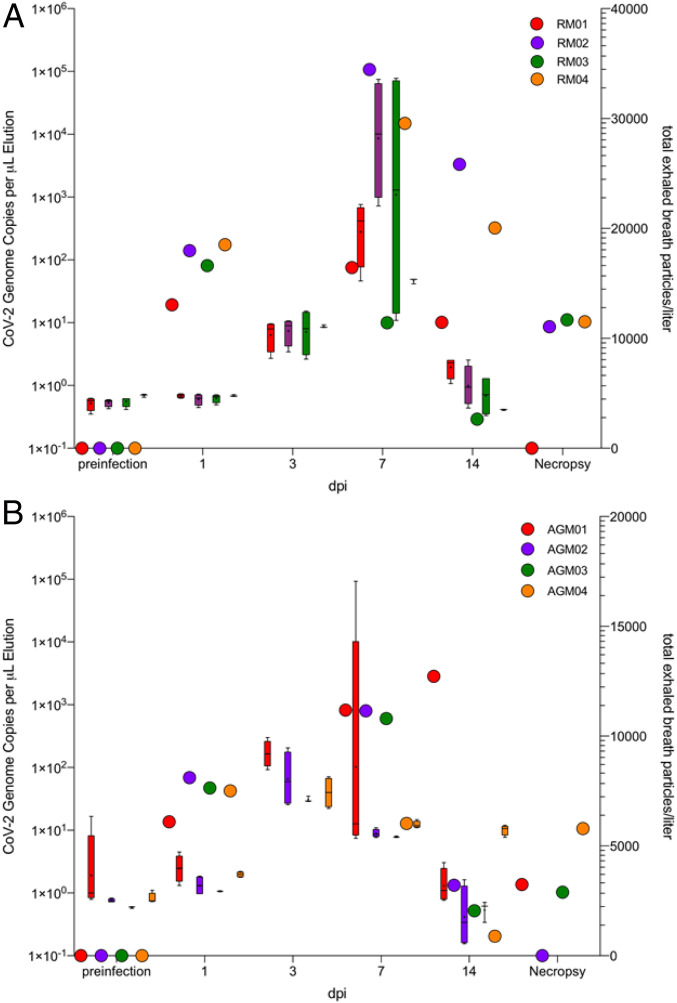
Exhaled breath particles and corresponding genomic SARS-CoV-2 viral RNA in experimentally infected (A) rhesus macaques (RM) and (B) African green monkeys (AGM). Both groups are segregated by species (n = 4; n = 8). The corresponding color-matched box-and-whisker plots of total exhaled breath particles represent iterative five 1-min sampling events to genomic viral RNA (color-matched circles) for each animal at each respective time point. Mean calculated correlation between time point-matched exhaled breath particle production and genomic viral RNA showed statistically significant correlations in 75% of the RM (RM01, r2 = 0.93, P < 0.03; RM02, r2 = 0.99, P < 0.004; RM04, r2 = 0.98, P < 0.0008) and 50% of the AGM (AGM02, r2 = 0.91, P < 0.04; AGM03, r2 = 0.97, P < 0.01).